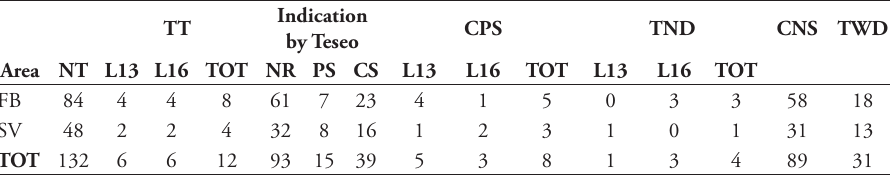
Table 6. Accuracy measurements in Forcella Buana (FB) and San Vito (SV) considering only larvae as target. NT: total number of trees investigated; TT: total number of target present in trees; L13 and L16: total number of trees colonised by larvae of O. eremita in 2013 and 2016 respectively; F+R: total number of trees in which frass (F) and/or remains of adults (R) were found in 2013 and 2016; NR: no reaction; PS: partial signalling; CS: complete signalling; CPS: correct positive signalling; TND targets non-detect- ed; CNS: correct negative signalling; TWD: target wrongly detected.